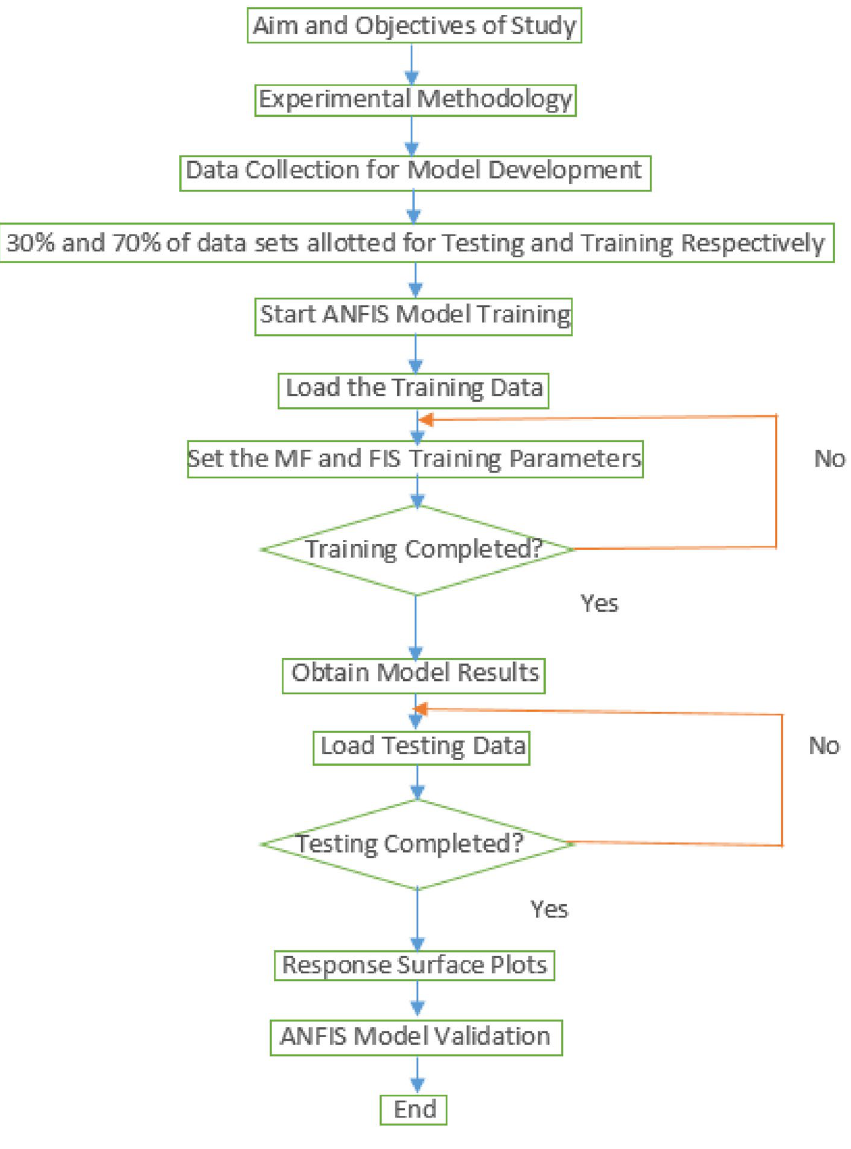
Figure 2. Research study